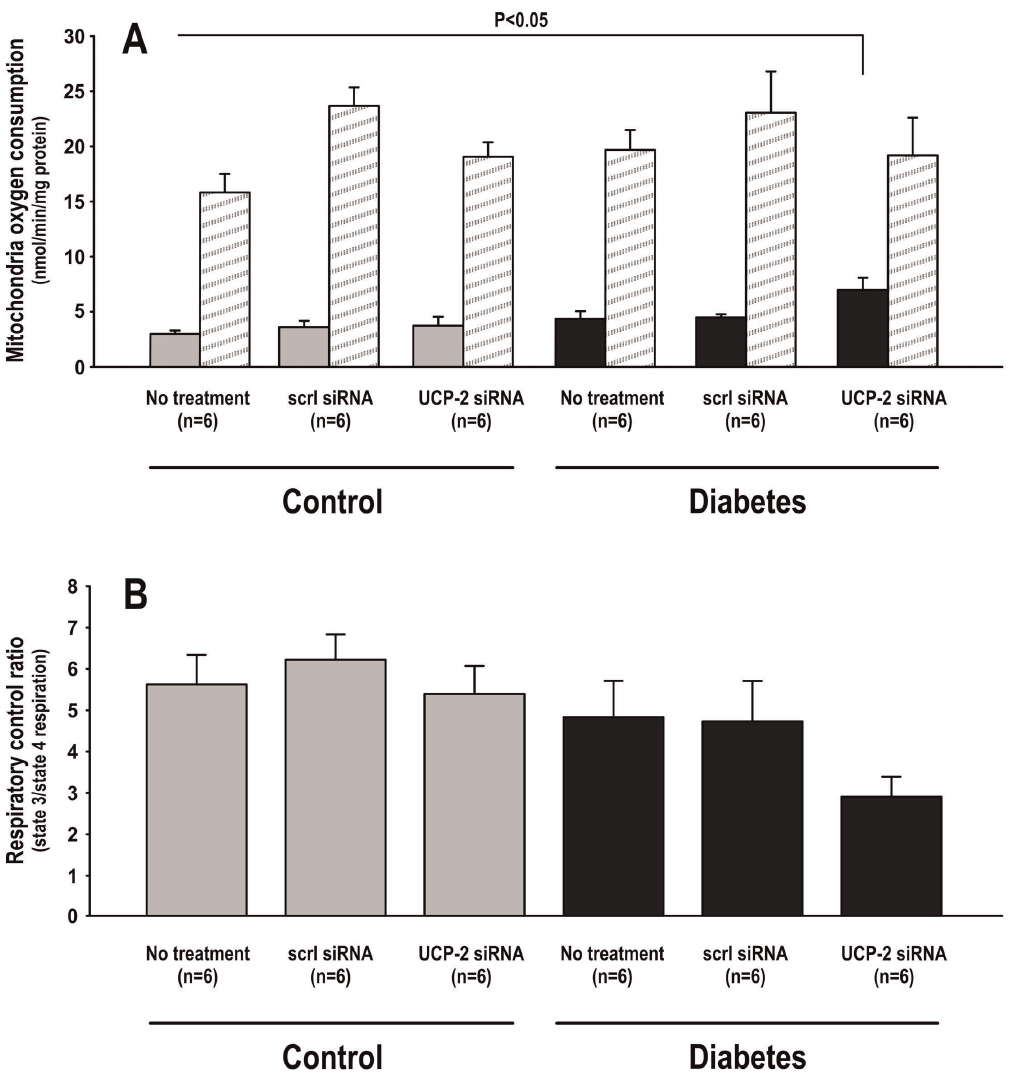
Figure 2. Mitochondria oxygen consumption measurements A) during state 4 (filled bars) and state 3 (patterned bars) in control and diabetic animals with and without scrambled or UCP-2 siRNA. B) Respiratory control ratio (state 3/state 4 respiration) in control and diabetic animals with and without scrambled or UCP-2 siRNA.